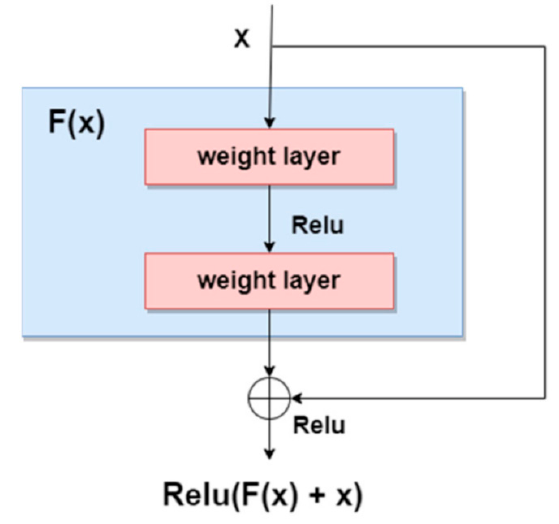
Figure 3. Residual block